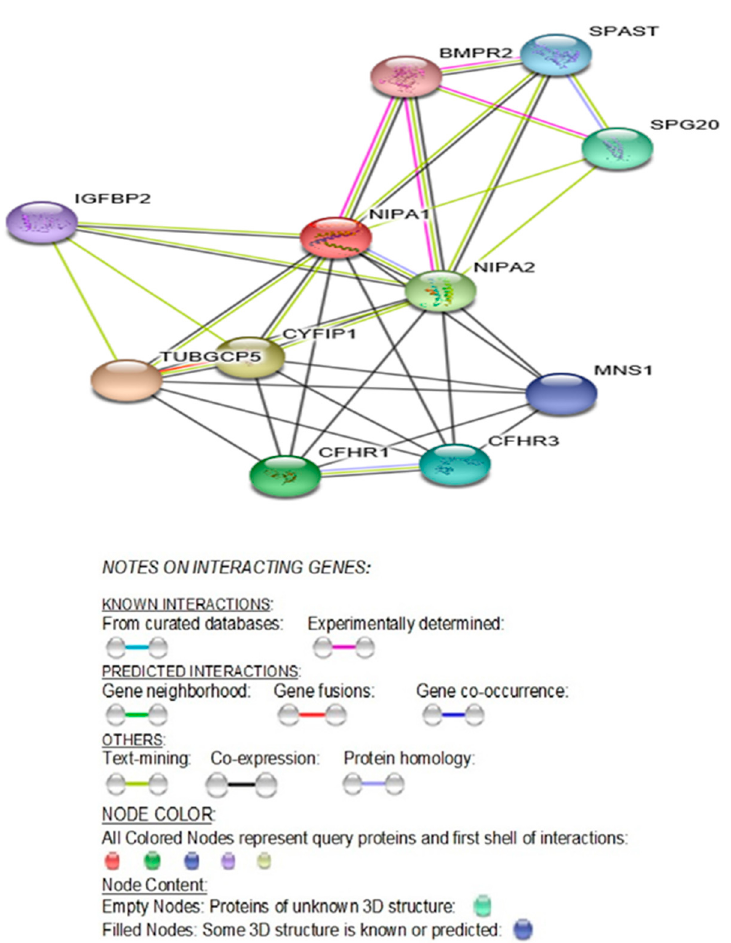
Figure 2. STRING Protein-Protein Interaction network involving NIPA1, NIPA2, CYFIP1, and TUBGCP5 genes with functional interactions showing 11 nodes (Table 1) and 34 edges and predicted functional interactions, such as, biological process (GO) and molecular function (GO) are given in Table 2, as designated in STRING: 9606.ENSP00000337452 ( STRING Consortium 2019 ). Network nodes represent proteins (Table 1) with splice isoforms or post-translational modifications collapsed into each node for all proteins produced by a single protein-coding gene. Edges represent protein-protein associations that are considered specific and meaningful, i.e., proteins jointly contribute to a shared function (Table 2).